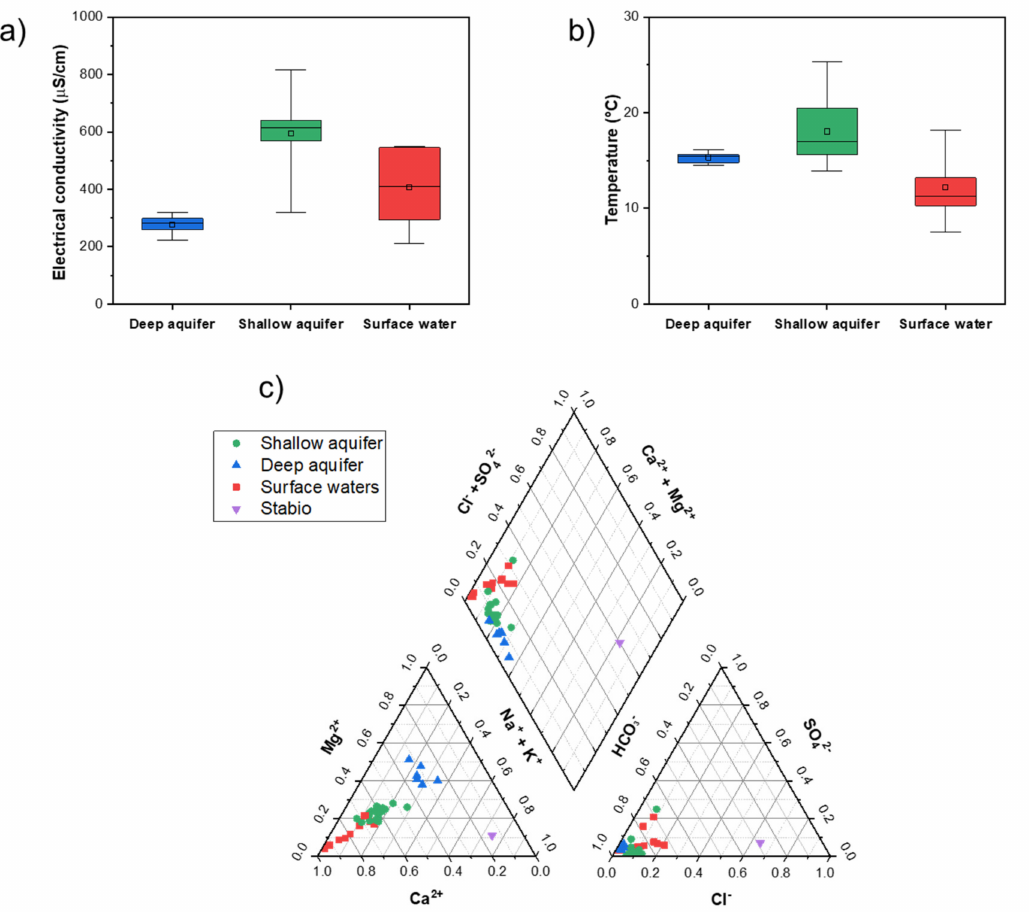
Figure 3. Box and whisker plot of electrical conductivity ( a ) and temperature ( b ) of the different aquifer and surface water samples. Boxes indicate the 25th–75th percentile range, whiskers indicate the minimum–maximum range, squares indicate the mean value and horizontal lines the median. ( c ) Piper plot of all the collected